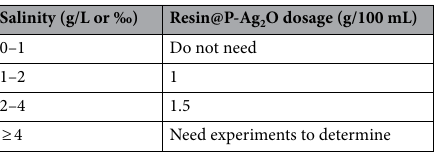
Need experiments to Table 1. Proposed resin@P-Ag 2 O amount for COD determination of salinity water.